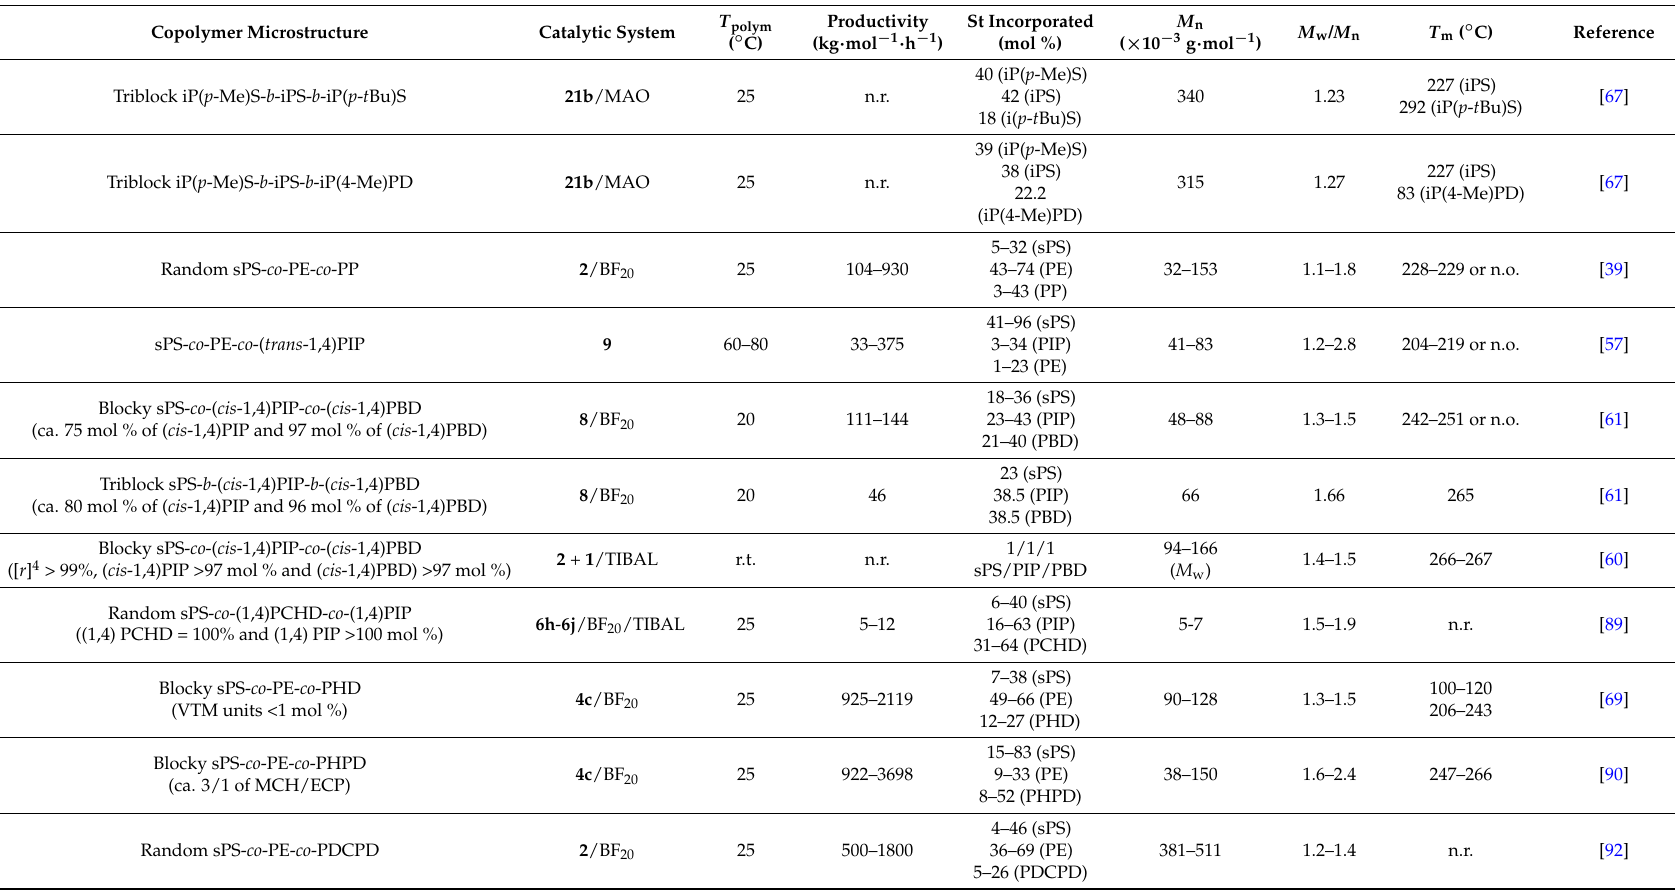
Table 6. Stereoregular styrene-based terpolymers: catalytic system and polymer